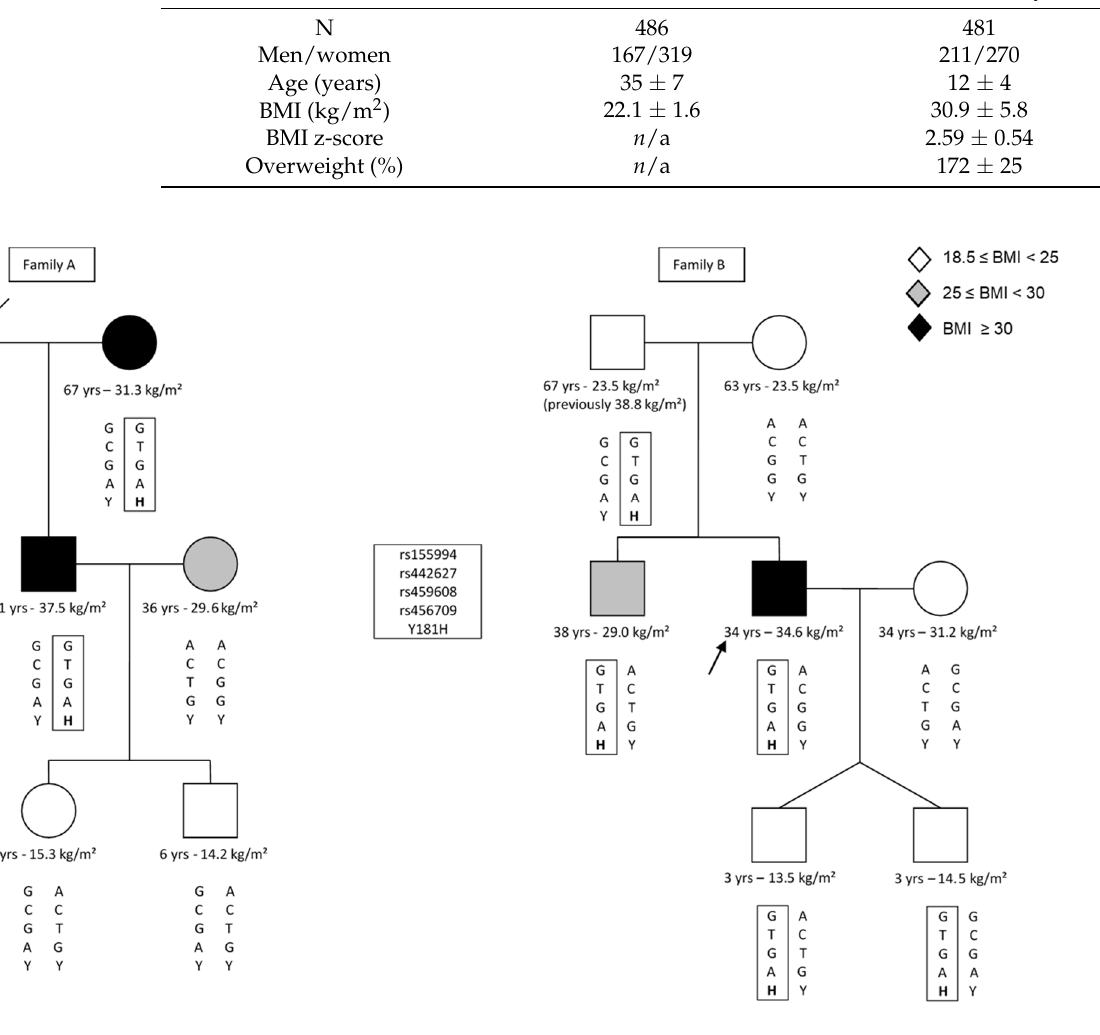
Figure 1. Pedigree of p.Y181H variant carrier families. Pedigrees are shown for both p.Y181H families (family A and B). The probands for each family are marked with an arrow. The first line below the symbols indicates the age of the individual at investigation, followed by his/her BMI. The genotypes for the investigated SNPs in intron 3 (rs155994, rs442627, rs459608, and rs456709, respectively) and p.Y181H in exon 4 are shown, with the common haplotype boxed.